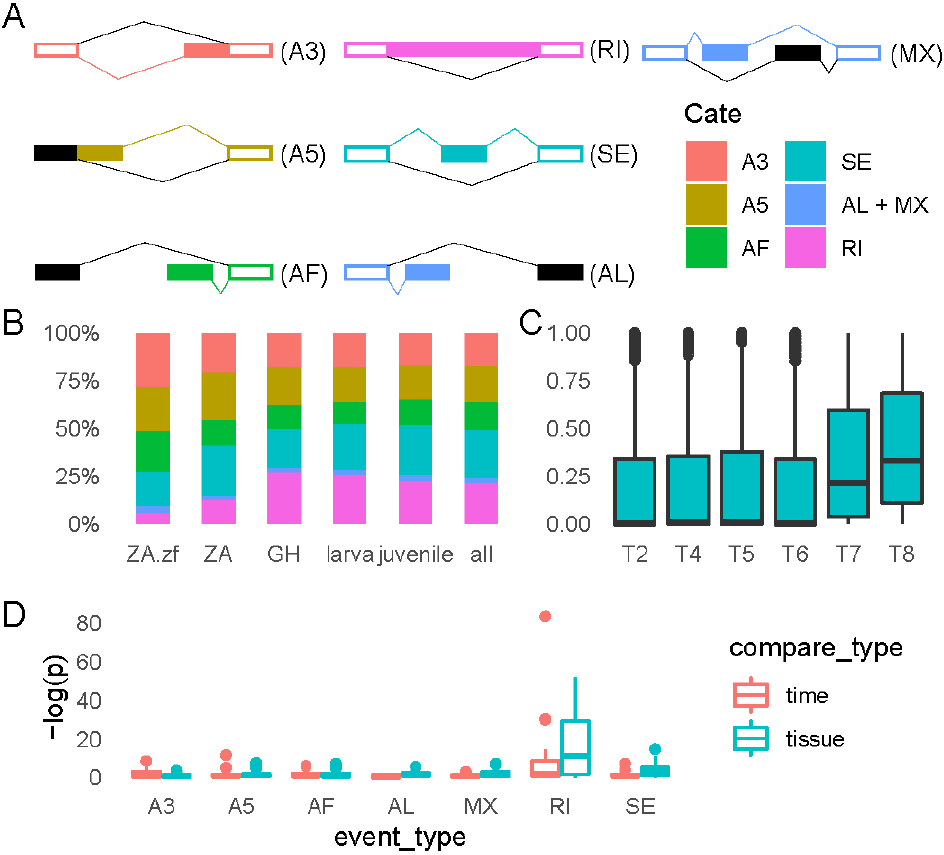
Figure 6. An examination of the various possibilities for splicing. ( A ) An example of a splicing pattern that has seven alternative splicing events that are fundamentally distinct from one another. In the diagram, the two distinct methods of splicing are indicated by the colors color and black, respectively. These colors represent the two possible outcomes of the process. The exons that are shared by both of the possible splicing types are denoted by the colored boxes that are otherwise empty. When the Ψ value is calculated, the colored splicing forms represent form 1; ( B ) The ratio of various alternative splicing events expressed at different stages. The ZA.zf indicates the ZGA stage of zebrafish [32]. Samples of grass carp were collected when the fish were in the ZGA stage (T2–T8), the GH stage (T9–T16), and the larva stage (T17–T20), respectively, as indicated by the letters ZA, GH, and larva, which are denoted by those letters. The statistical analysis was carried out on each and every sample of grass carp; ( C ) The variations in the values Ψ of alternative splicing events of the RI type that occurred during the ZA period; ( D ) A description of the distribution of the p- value. Classification of the comparison: tissue shows that the comparisons were carried out between 9 tissue samples pairwise and time indicates that the comparisons were carried out between adjacent time intervals in the time series samples from T2–T20.